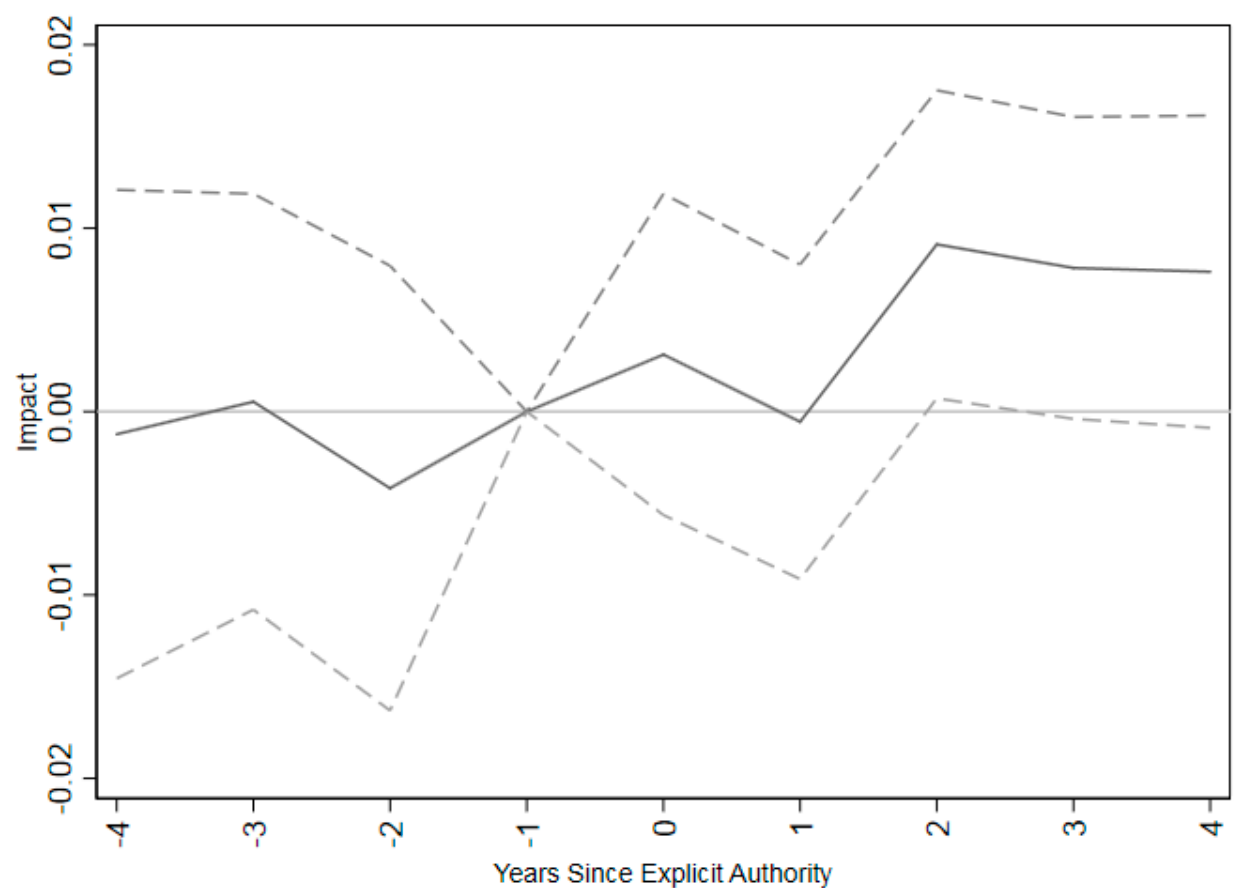
Figure 2. Event study for impact of pharmacists’ explicit authorization to vaccinate on influenza vaccination coverage rates for adults age 65+. Note: The figure shows coefficients (connected by solid lines) and 95% confidence intervals (connected by dashed lines) for a regression of influenza vaccination coverage rates on time relative to implementing explicit permission for pharmacists to administer vaccinations. The omitted category is one year prior to vaccination. The regression includes only states that have at least 4 years of vaccination data before and after granting explicit authority to administer vaccines for pharmacists. Regressions are at the individual level, weighted by appropriate survey weight from BRFSS data and clustered at the state level. Individual controls include dummies for income in bins, marital status, educational attainment, white, black, Hispanic, insurance status, and unemployment status as well as age as a continuous variable.